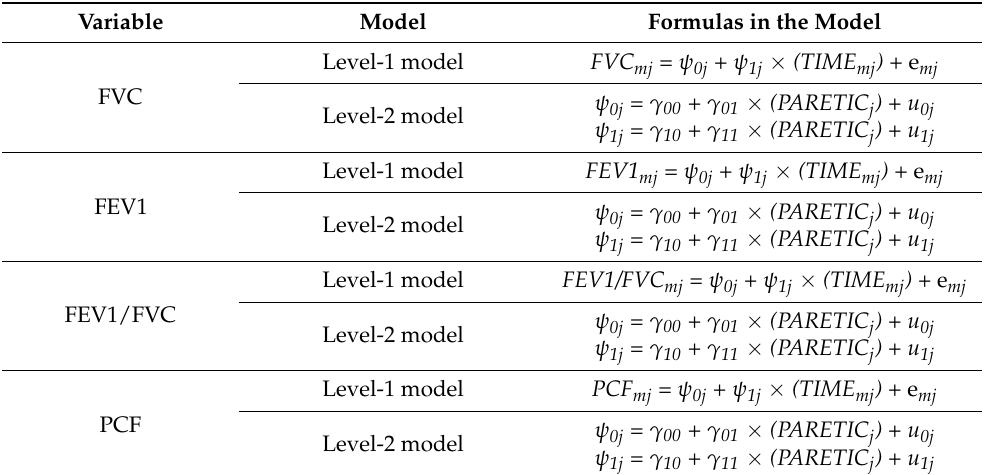
Table 3. Composition of the research model.